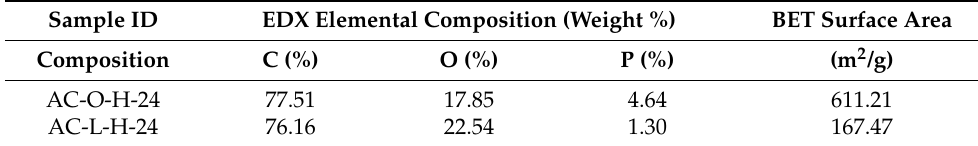
Table 4. EDX elemental composition and BET surface area of activated carbon.